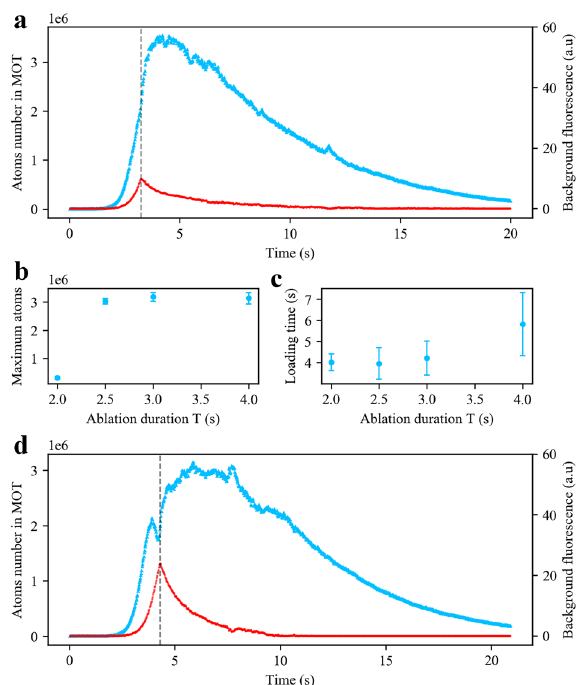
Figure 4. Experimental results of the long pulse sequence. ( a ) Temporal evolution of the fluorescence signal of the cold atoms cloud (light blue triangles) and the strontium vapour (red circles) for an ablation duration of T = 3 s, and a laser power of 20 W. The vertical dashed line shows the time at which the ablation laser turns off. ( b ) The peak cold atoms number as a function of ablation duration T . Fluorescence signals are observed when T ≥ 2 s. ( c ) Loading times (time taken to reach the peak atoms number value after the ablation laser ignition) as a function of the ablation duration T . ( d ) Temporal evolution of the fluorescence signal of the cold atoms cloud (light blue triangles) and the strontium vapour (red circles) for an ablation duration of T = 4 s, and a laser power of 20 W. The vertical dashed line indicates the time at which the ablation laser turns off. In ( a ) and ( d ), the time origin corresponds to the laser ablation